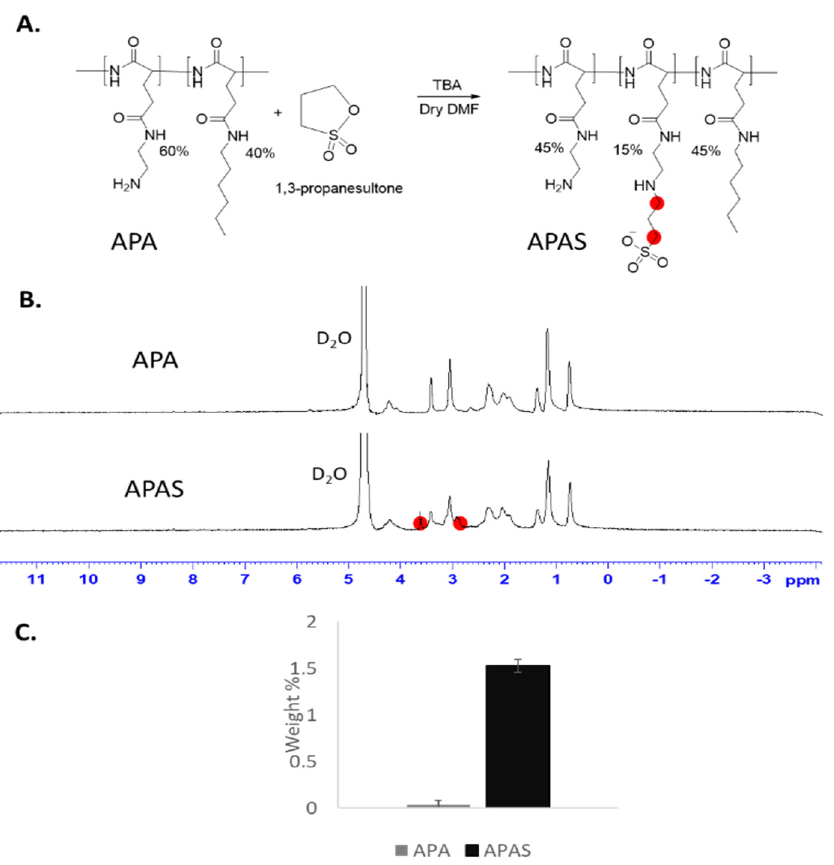
Figure 5. Synthesis and characterization of APAS. ( A ) Modification of APA with sulfonate groups using propanesultone. ( B ) 1 H-NMR spectrum of APA and APAS in D 2 O. ( C ) Elemental analysis demonstrating the weight percent of Sulfur (S) in dry samples of APA and APAS, as obtained by energy-dispersive X-ray spectroscopy (EDS) analysis.